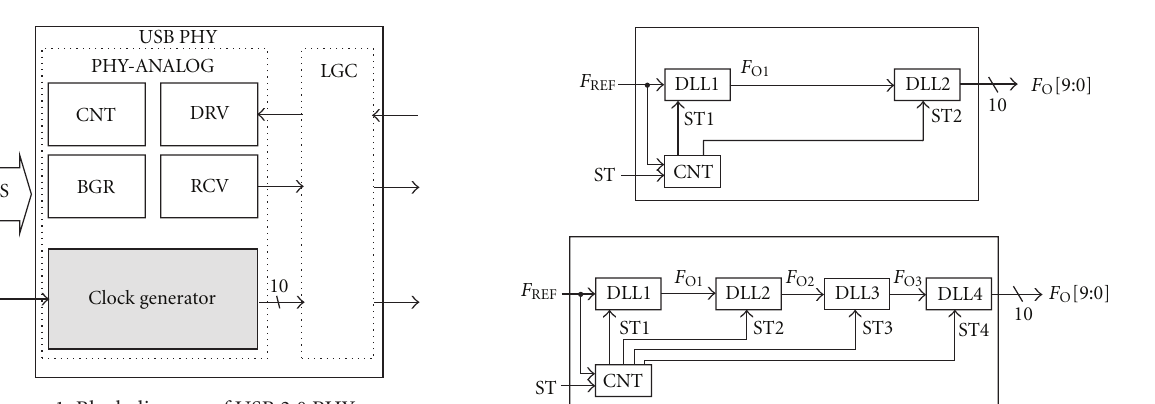
Figure 1: Block diagram of USB 2.0 PHY. Figure 3: Block diagrams of candidate clock generator based on DLLs. Upper block diagram is the structure that consists of one ECDLL and one DLL. The ECDLL has a multiplication ratio of 40. Bottom block diagram is the structure that consists of three ECDLL and one DLL. The DLL1, DLL2, and DLL3 have multiplication ration of two, four, and five, respectively.